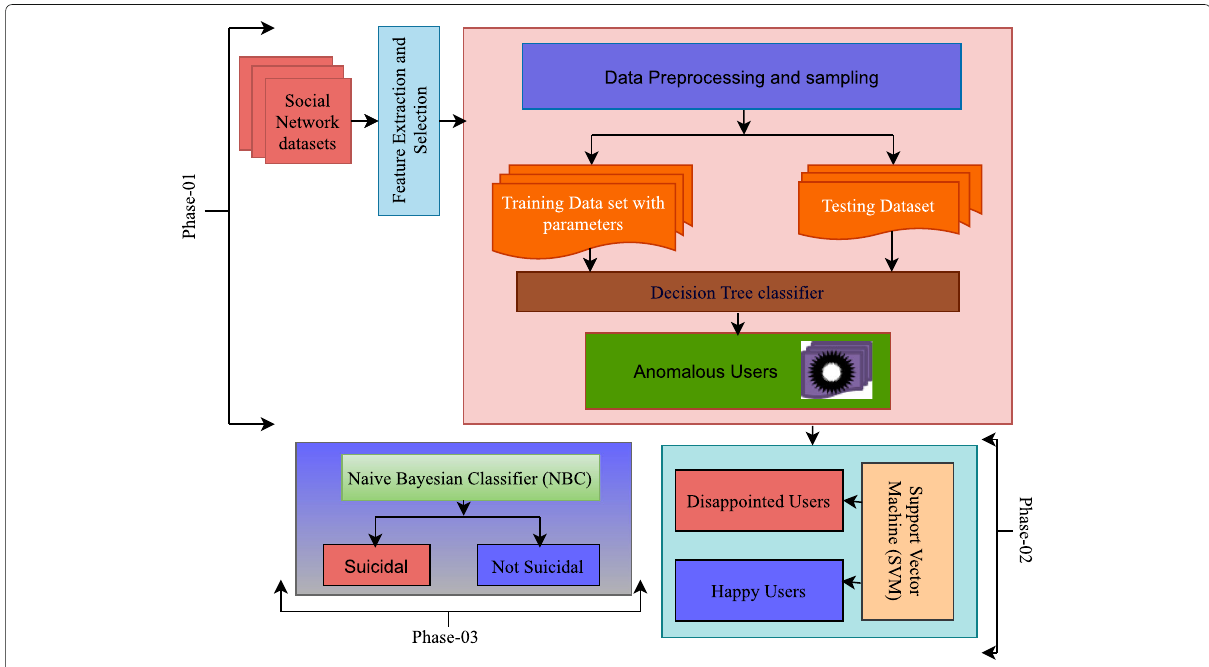
Fig. 3 Proposed framework for anomaly